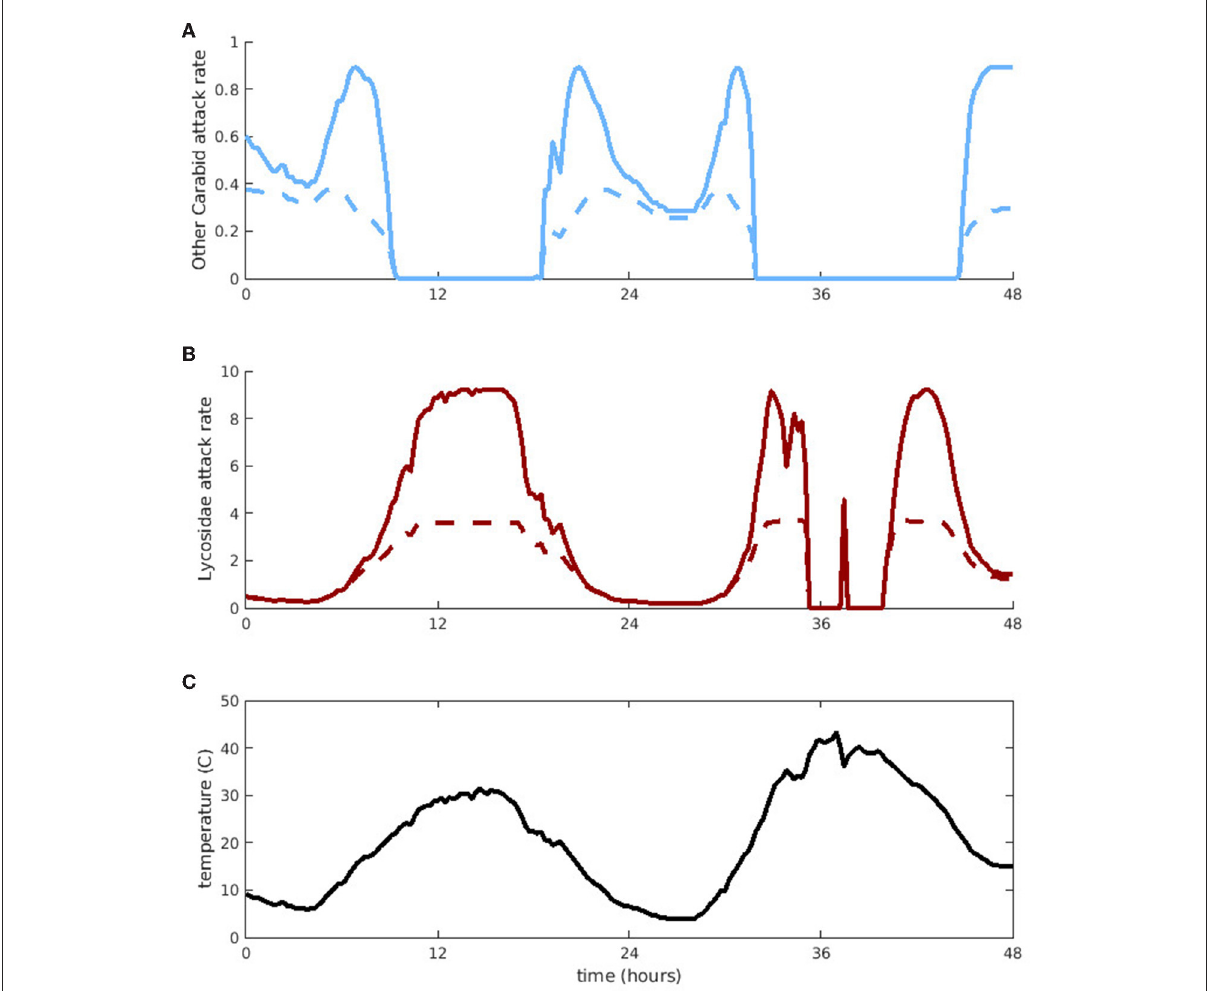
FIGURE2 Per-capita aphid attack rates by “Other Carabid” and Lycosidae , as a function of time. (A) Is “Other Carabid” attack rate and (B) is Lycosidae attack rate. Solid lines denote the full potential attack rate and dashed lines denote the effective attack rate accounting for interference due to intraguild predation. (C) Indicates the corresponding temperatures for these attack rates, taken over 2 days in one of the